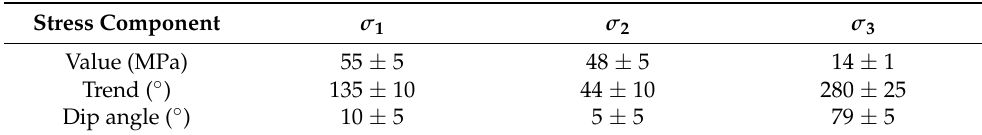
Table 5. In situ stress at elevation